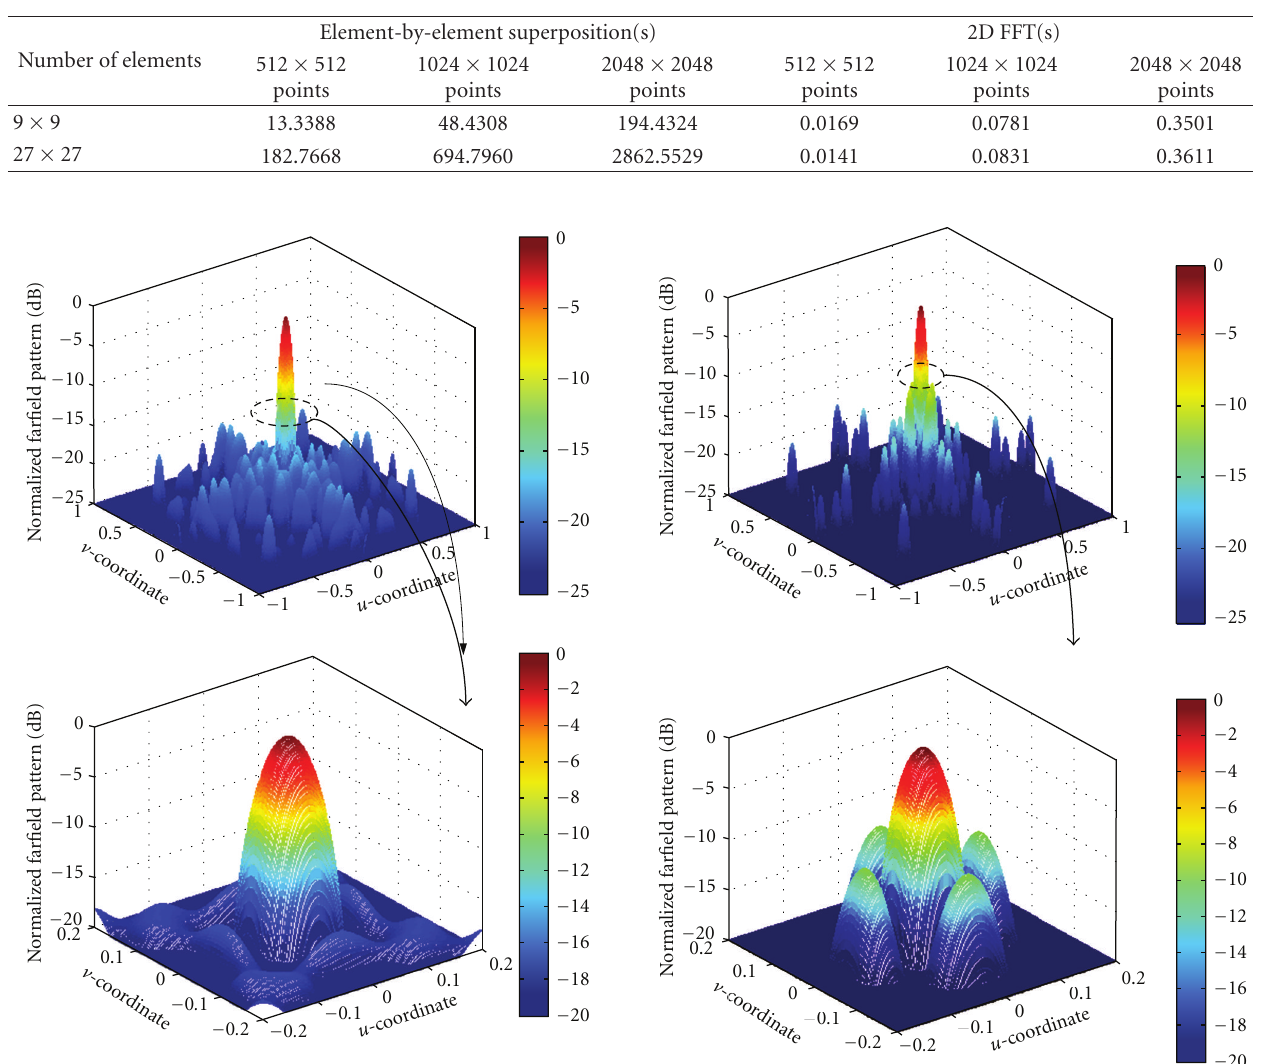
Table 1: Average-time comparison for computing the planar-array pattern with di ff erent methods.